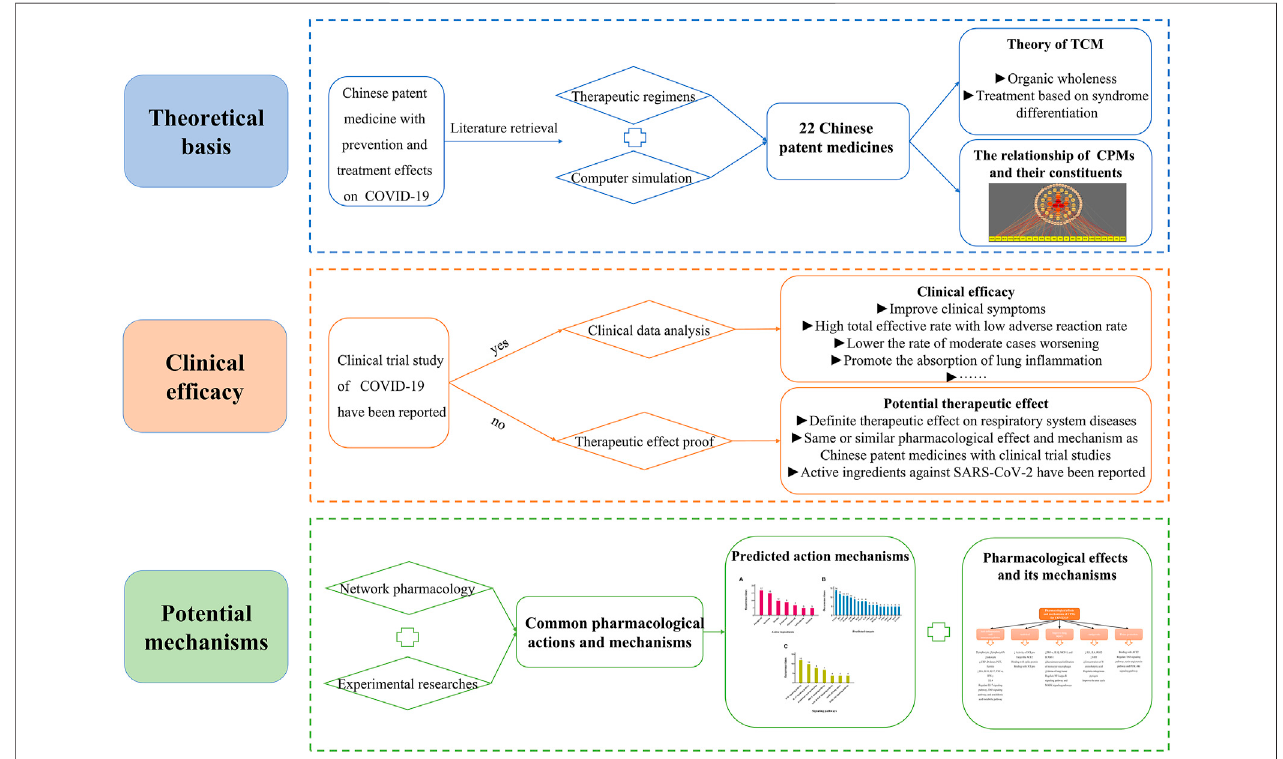
FIGURE 1 | Graphical